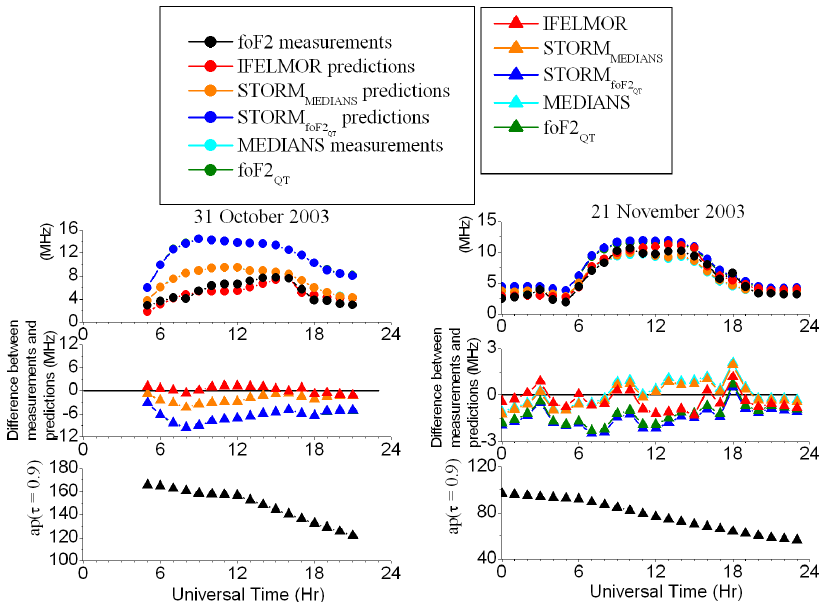
Fig. 10. Same as Fig. 8, but for disturbed ionospheric conditions on 31 October and 21 November 2003. IFELMOR works better than both STORM MEDIANS and the median measurements for 21 November 2003 even if the comparison does not show significant differences. More significant differences appear from the comparison between IFELMOR and STORM fo F2 QT as well as between IFELMOR and the fo F2 QT values as confirmed by the values of the r.m.s. reported in Table 5. IFELMOR provides much better predictions for 31 October 2003. In this case very significant differences emerge from the comparison between IFELMOR and STORM MEDIANS as well as between IFELMOR and the median measurements. In particular the comparison between IFELMOR, STORM fo F2 QT , and the fo F2 QT values shows remarkable differences as confirmed by the values of the r.m.s. reported in Table